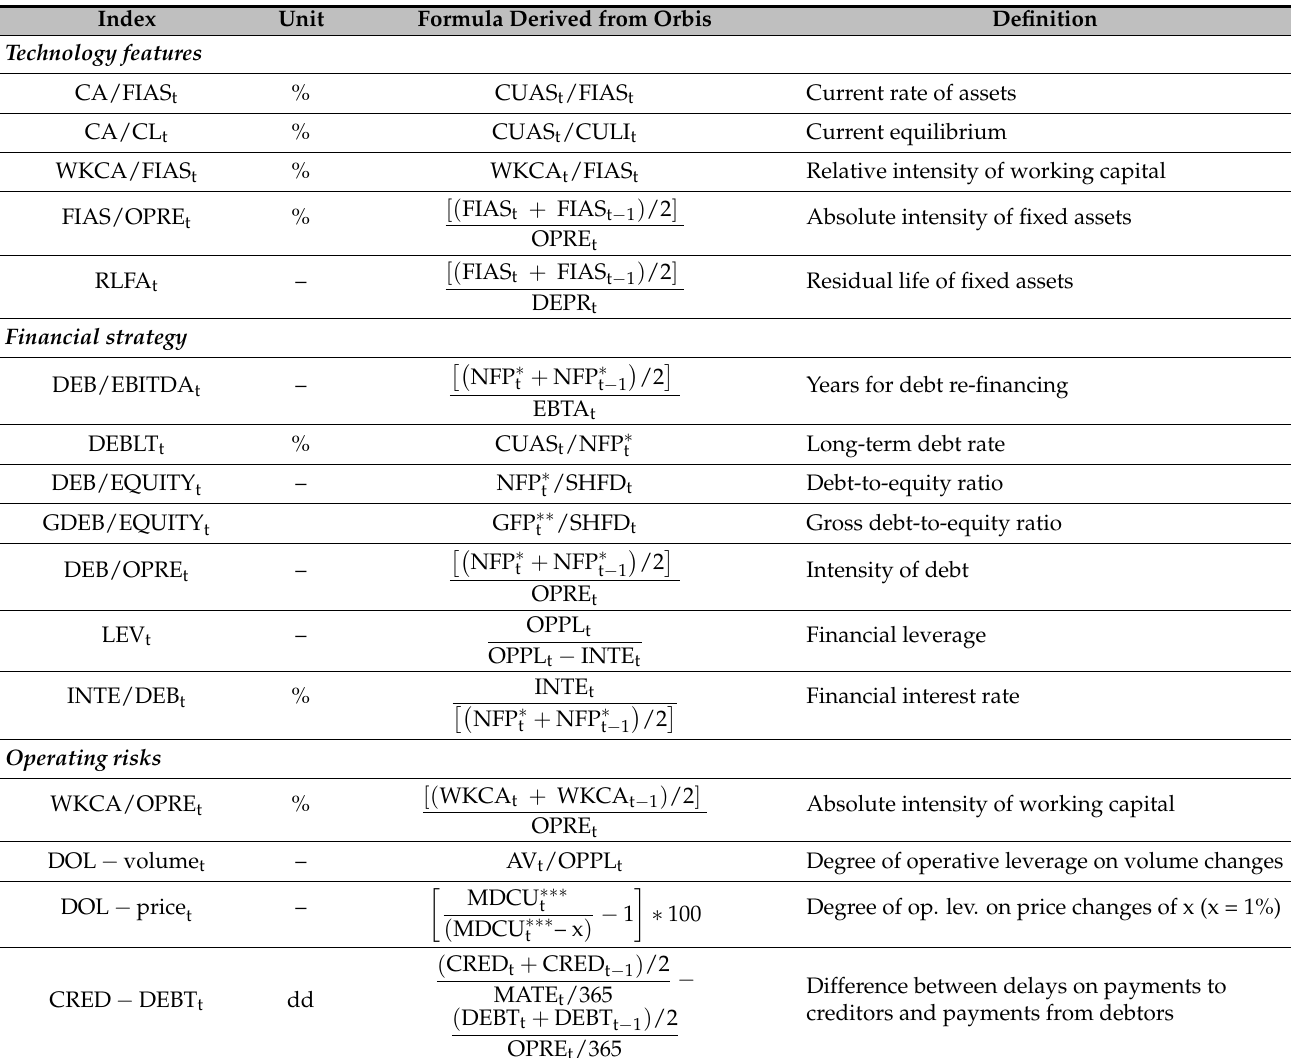
Table A1. Indexes’ label, formula and